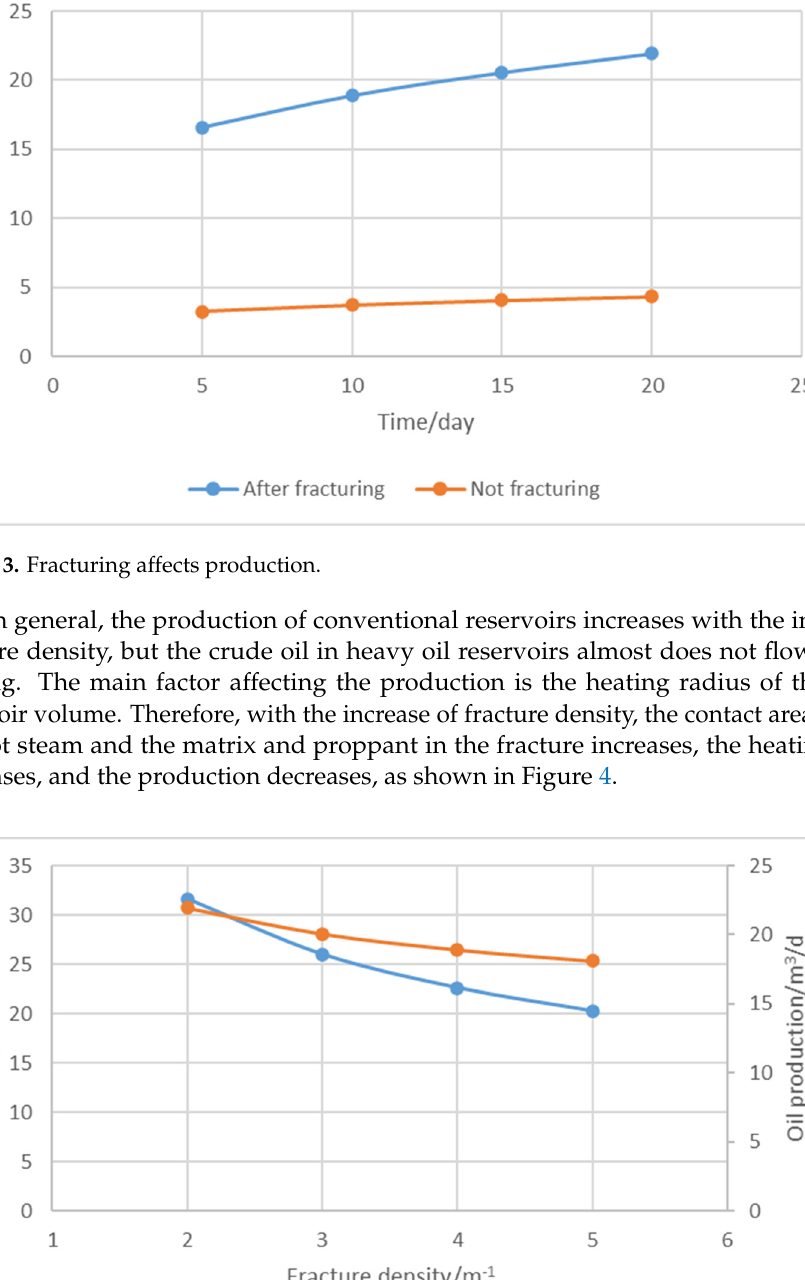
8 of 10 Figure 2. Curve of heating radius with time.